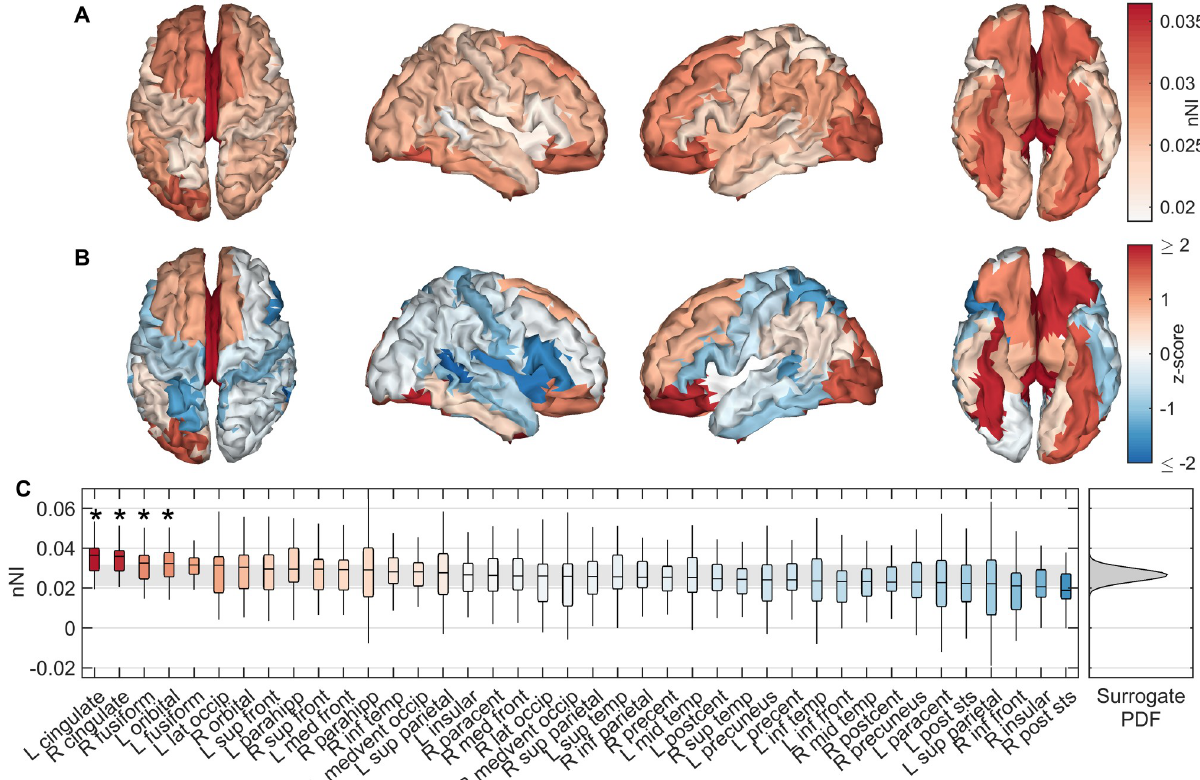
Fig 3. Spatial distributions of seizure generating regions in AD simulations. (A) Median nNI over participants for each ROI. (B) z -scores of median nNI against the surrogate distribution. Red scores suggest the nNI score was larger than expected from a homogeneous distribution, suggesting these regions are most strongly responsible for generating seizures. (C) nNI values for regions sorted by median over participants by descending nNI. Background colour shows z -score. The shaded grey region shows empirical 95% confidence intervals on the surrogate data, while the full (Gaussian) probability density function of the surrogate data is shown on the right. ROIs marked by an asterisk were significant to (FDR corrected) p < 0.05. Full names of ROIs along with the abbreviations given here are given in S1 Table. Parameters are those given in Fig 2.